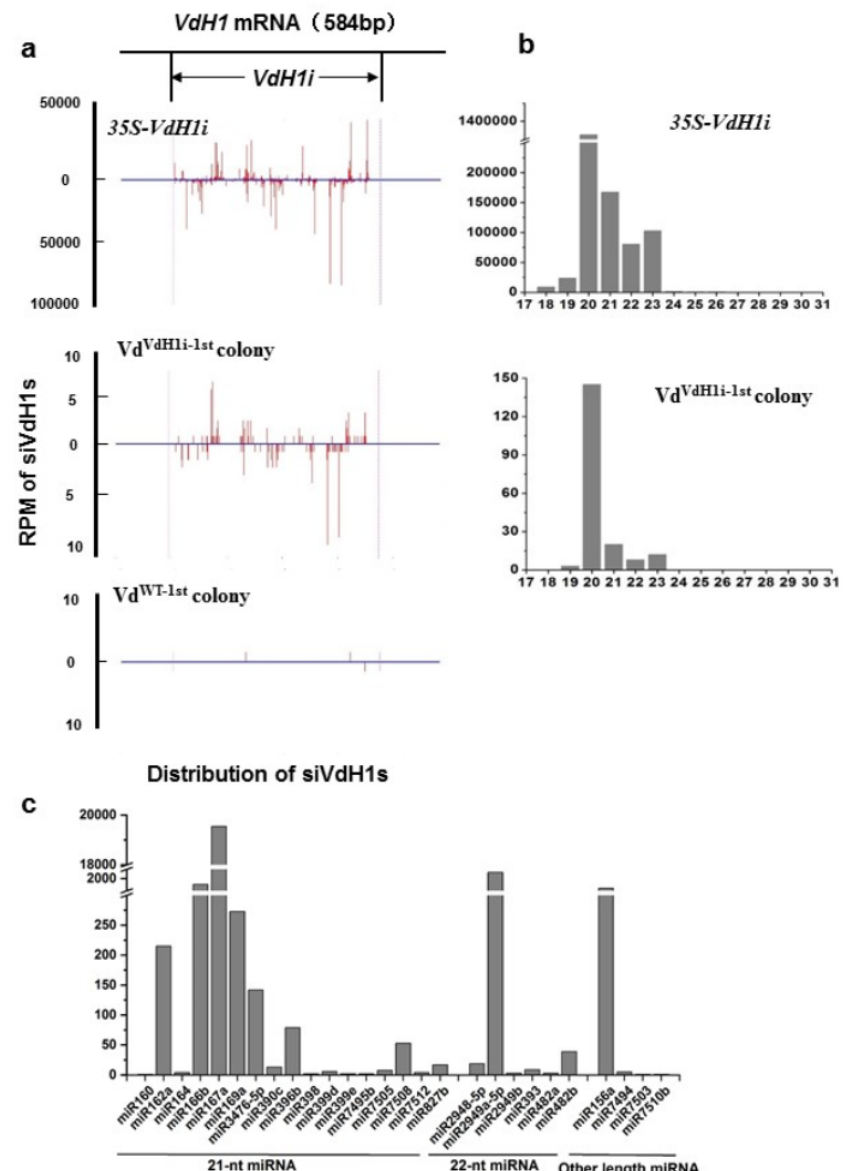
Figure 1. Small RNA analysis of 35S-VdH1i transgenic cotton, Vd VdH1i − 1st , and Vd WT − 1st colonies. ( a ) RPM (reads per million sequences) and distribution of siVdH1s obtained by deep sequencing. The 5 (cid:48) -terminal 380bp VdH1i region is indicated. The y-axes represent the RPM of siVdH1s in small RNA libraries of 35S-VdH1i cotton, Vd VdH1i − 1st colonies, and Vd WT − 1st colonies related to positions along the VdH1 gene indicated in x-axes. siVdH1s (in red vertical lines) above and below the 0 value of y-axes indicate the sense and antisense orientation, respectively. ( b ) Length distribution of siVdH1s in 35S-VdH1i cotton and Vd VdH1i − 1st colony. ( c ) Length distribution of cotton endogenous